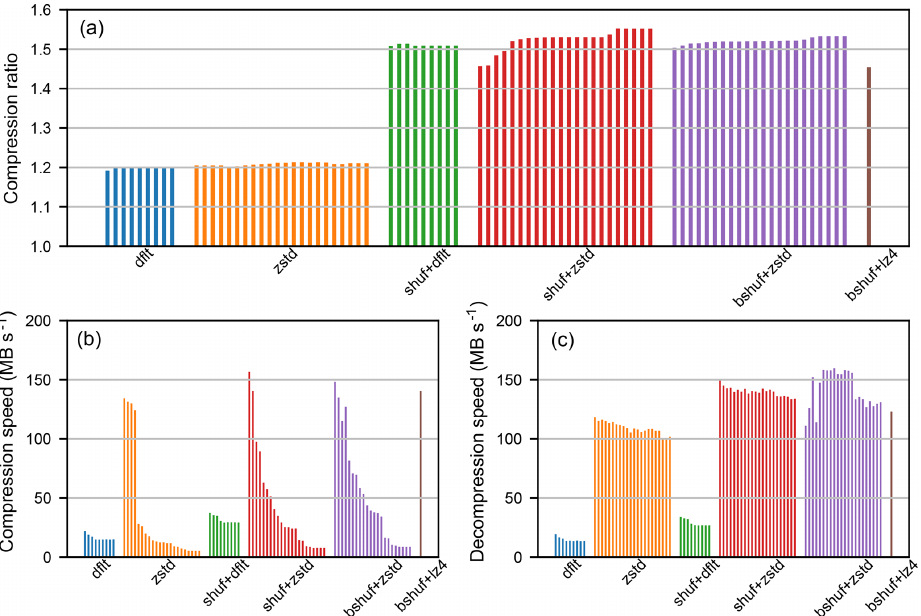
Figure 2. Results obtained for the lossless compression of the s1 dataset with Deflate (dflt), Zstandard (zstd), Shuffle and Deflate (shuf + dflt), Shuffle and Zstandard (shuf + zstd), Bitshuffle and Zstandard (bshuf + zstd), Bitshuffle and LZ4 (bshuf + lz4). Compression ratios (a) , com- pression speeds (b) , and decompression speeds (c) . Vertical bars represent the results for different compression levels: from 1 to 9 for Deflate, from 1 to 22 for Zstandard, only one level for LZ4.